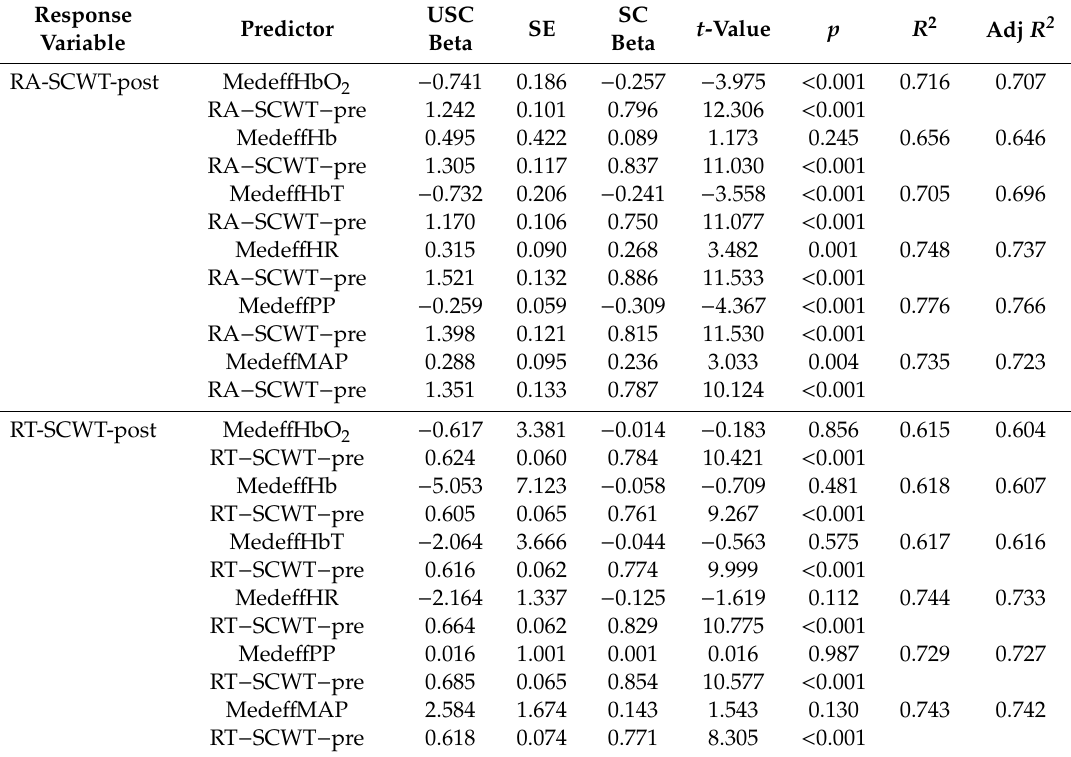
Table 3. Separate linear regressions of meditation e ff ects with hemodynamic measures obtained by fNIRS ( n = 20), physiological measures ( n = 10), and pre-meditation Stroop behavioral measures on the Stroop behavioral measures